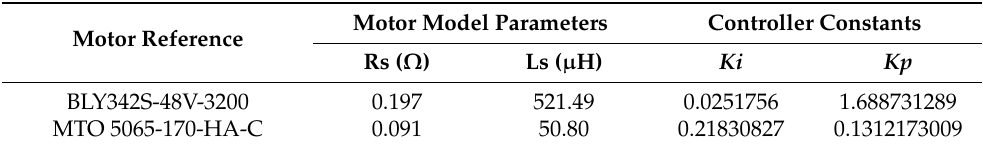
Table 4. Motor and controller